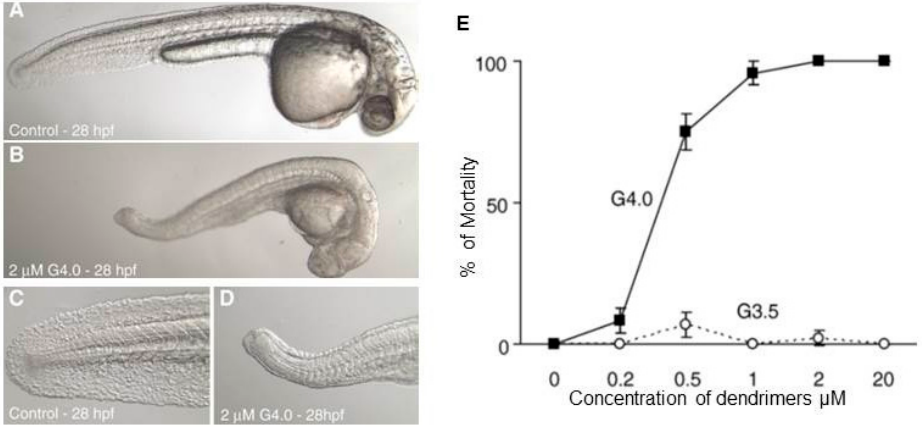
Figure 5. Representative micrographs of overt toxicity seen in zebrafish embryos exposed to control or 2 μ M G4 dendrimers beginning at 6 h post fertilization (hpf). All micrographs were taken at 28 hpf. ( A ) Control embryo manually removed from chorion (magnification 3.2×). ( B ) G4 dendrimer-treated embryo manually removed from chorion (3.2×). ( C ) Higher magnification of tail of control embryo (10×). ( D ) Higher magnification of tail of G4 dendrimer-treated embryo (10×). ( E ) Mortality of zebrafish embryos at 120 hpf following exposure to G4 and G3.5 PAMAM dendrimers from 6 to 120 h post fertilization (hpf). Figure reproduced with permission from [145].